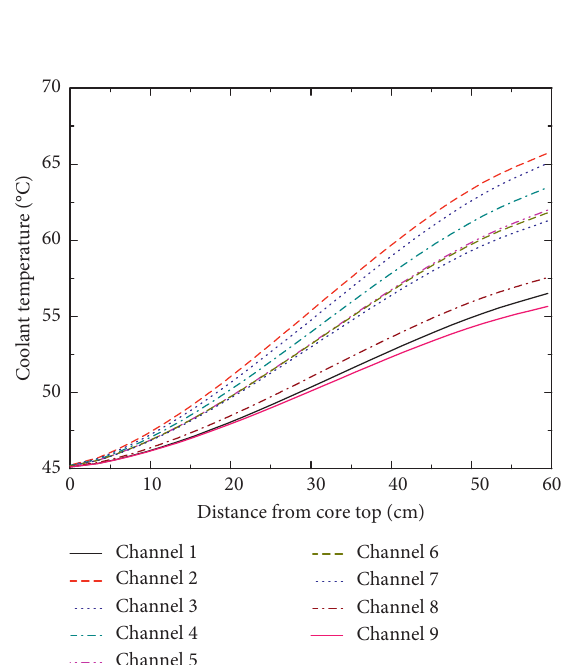
Figure 9: Axial profile of coolant temperature in the channels of the hottest fuel assembly. The channels are numbered from outer to inner channels of the FA.